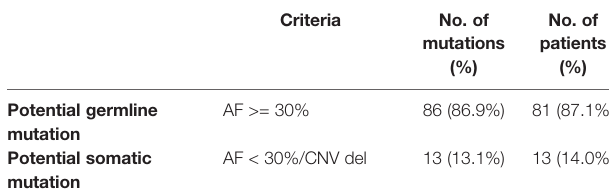
TABLE 2 | Estimated proportion of germline/somatic HRR